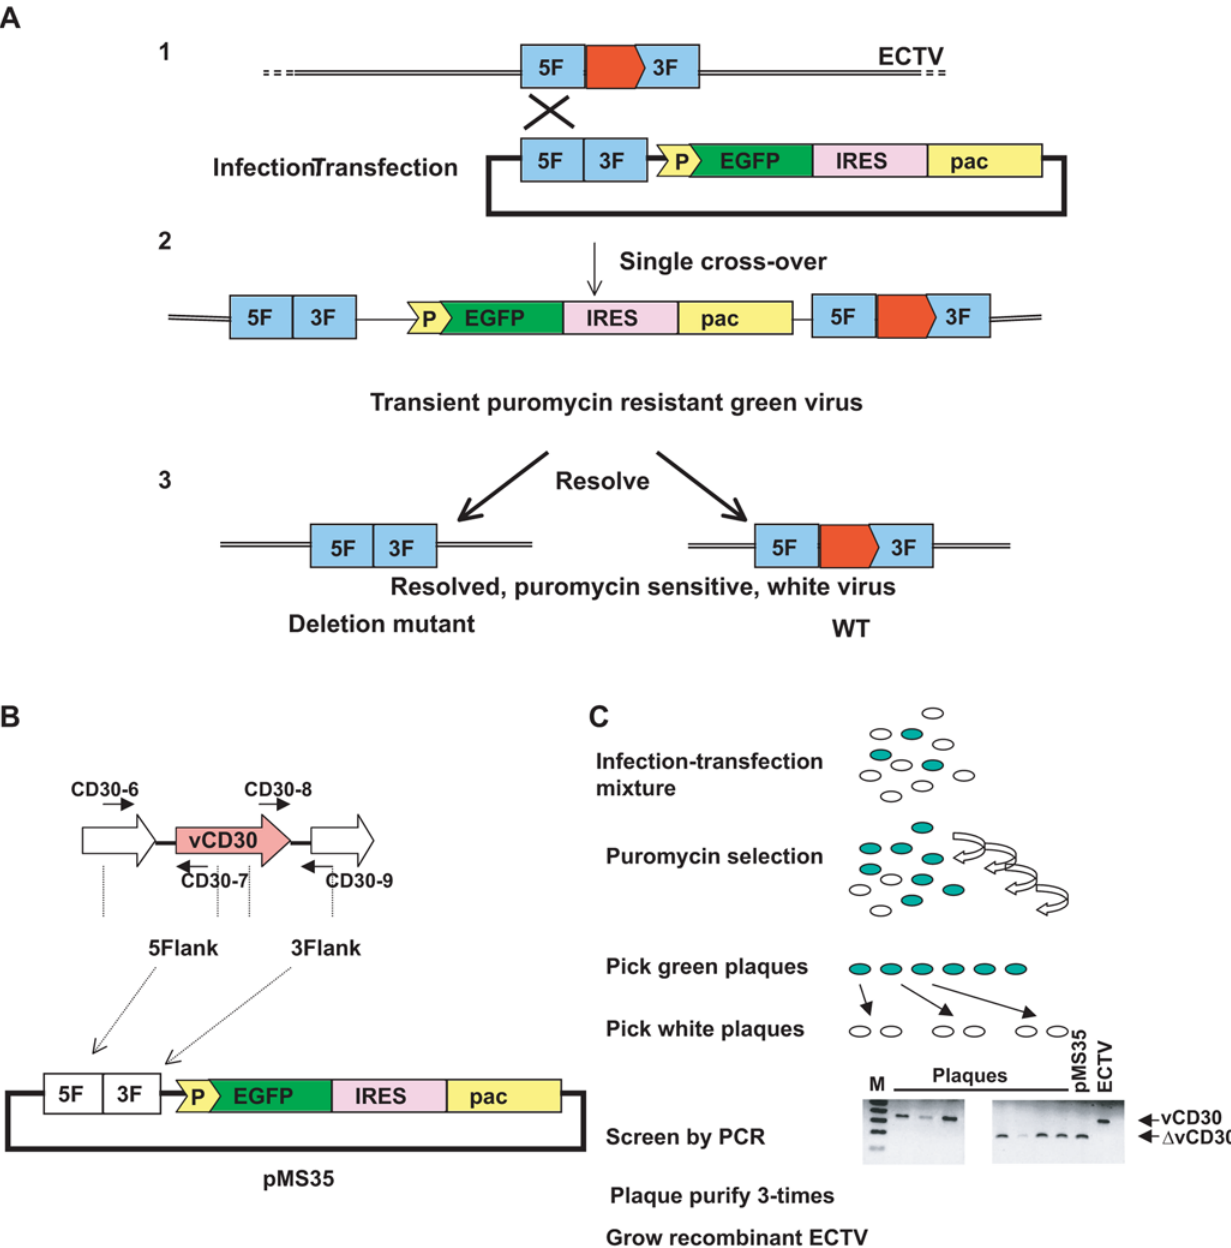
Figure 1. Transient dominant selection for the generation of ECTV recombinant viruses. A. Schematic representation of the recombination events between the viral genome and the plasmid as well as the phenotypes of intermediate and final viruses obtained during the procedure. B. Representation of the plasmid pMS35 used for the generation of the ECTV D CD30 virus. The vCD30 locus and the primers used for amplification of the flanking regions are indicated. C. Flowchart of the main steps in the generation of the ECTV D CD30 virus. doi:10.1371/journal.pone.0005175.g001 puromycin. This intermediate virus can be isolated by allowing the recombinant plasmid containing approximately 500 bp of the 5 9 virus to replicate during several passages and to be amplified in the and 3 9 flanking regions of the gene to be deleted and a presence of the antibiotic, which causes cells to detach and does downstream expression cassette that allows for selection not allow plaque assays. A subsequent plaque assay on cell (Figure 1B). Homologous recombination between viral DNA monolayers in the absence of puromycin selection enables picking sequences present in the recombinant plasmid and genomic of plaques which appear green under UV-light examination ECTV DNA produces recombinant viruses formed by a single (Figure 1C). In a second step, perfomed on cell monolayers in the cross-over event that inserts the complete plasmid into the ECTV absence of selection, another recombination event occurs, genome. The intermediate viral species transiently expresses the resulting in the resolution of the intermediate virus and leading selectable markers, EGFP, which can be visualized under the to the formation of either a virus lacking the targeted gene or to fluorescence microscope and pac, which confers resistance to